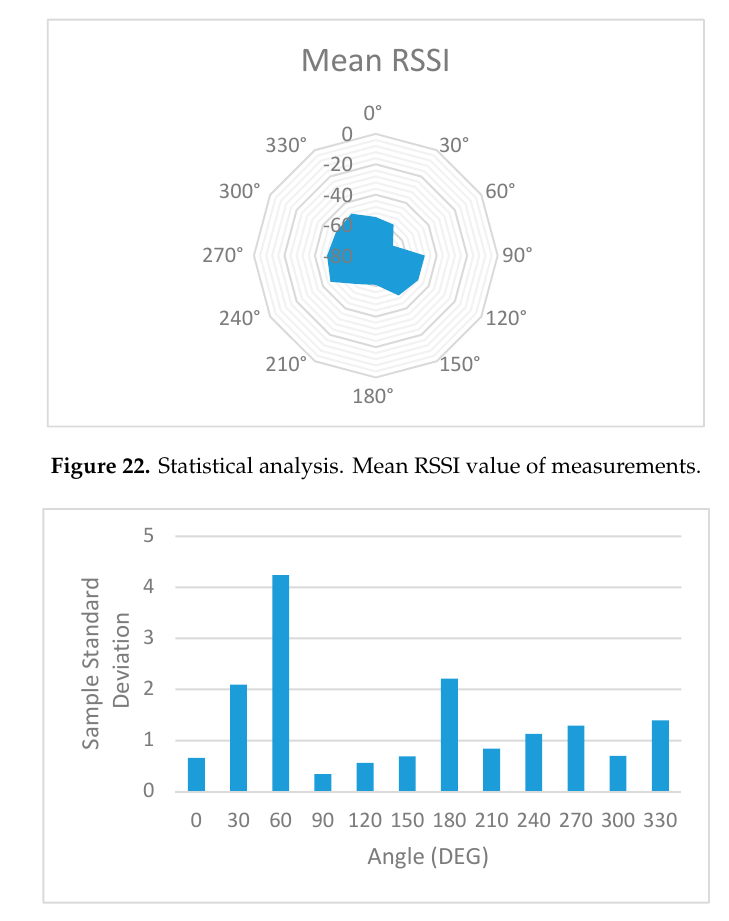
Figure 23. Statistical analysis. Sample standard deviation of RSSI measurements.